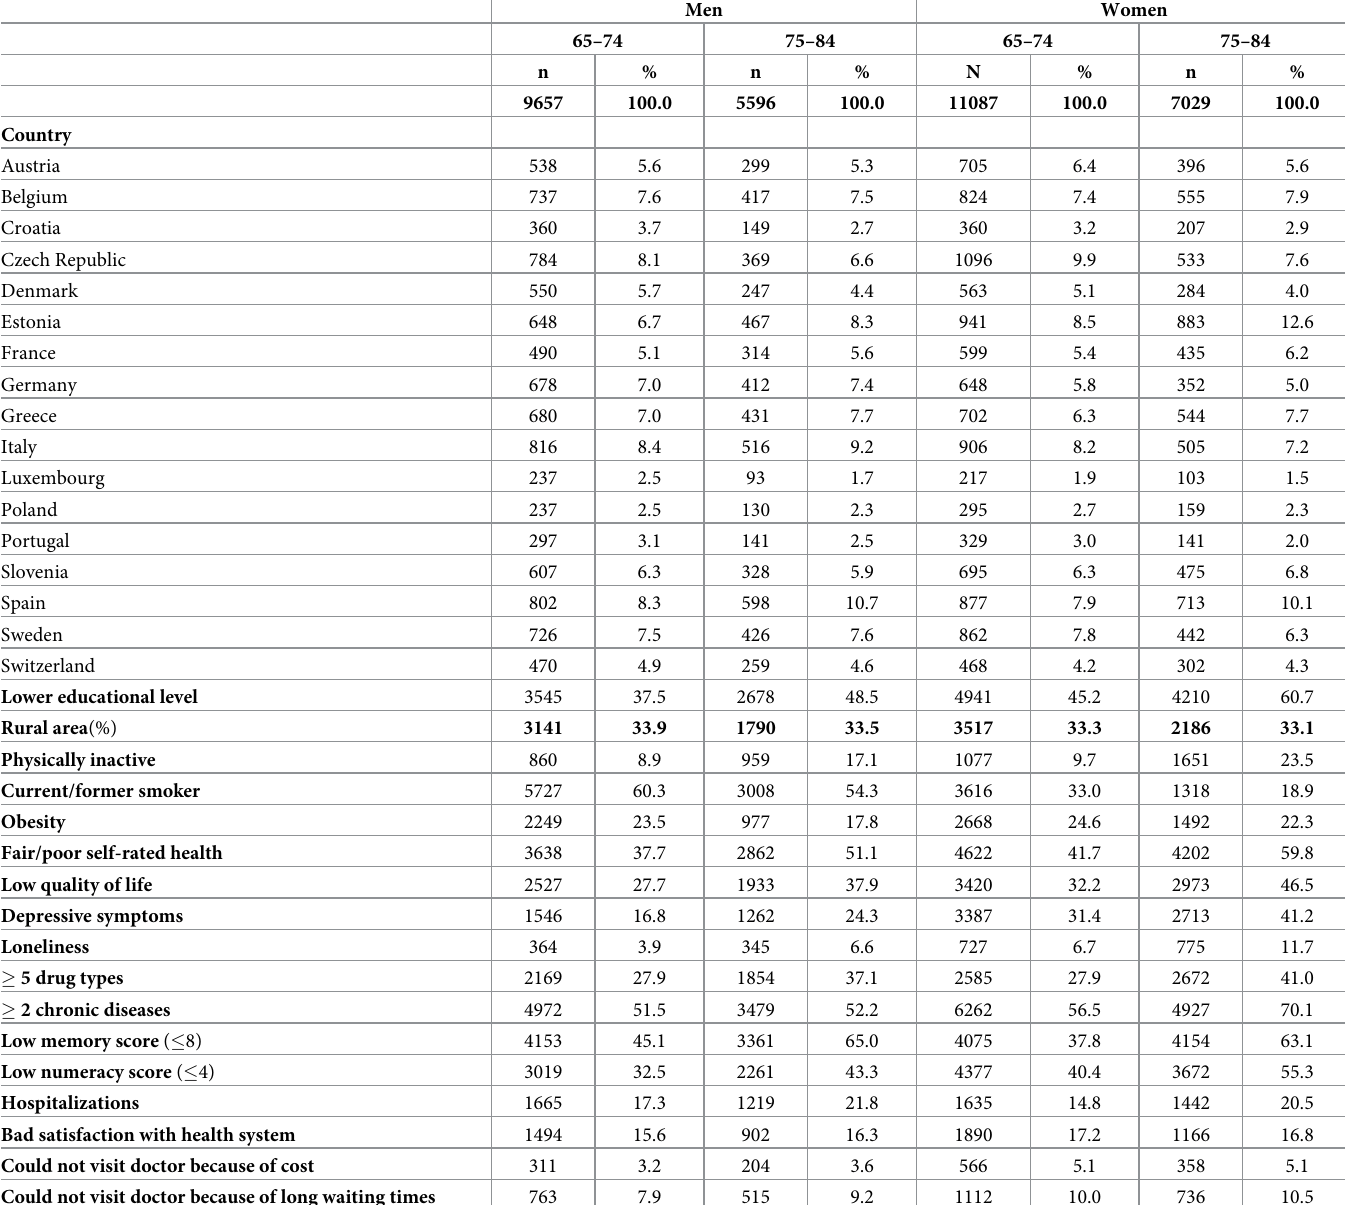
Table 1. Weighted descriptive analysis (absolute and relative frequencies) of the independent variables in the sample of community-dwelling European older adults, by gender and age group in